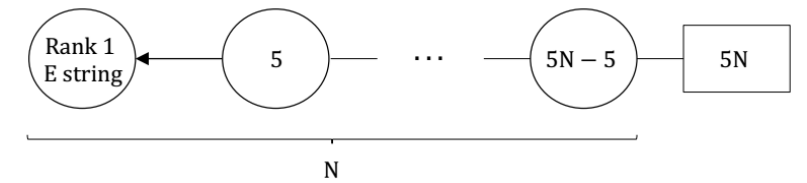
Figure 12 . A 6 d quiver describing a 6 d SCFT on a generic point on the tensor